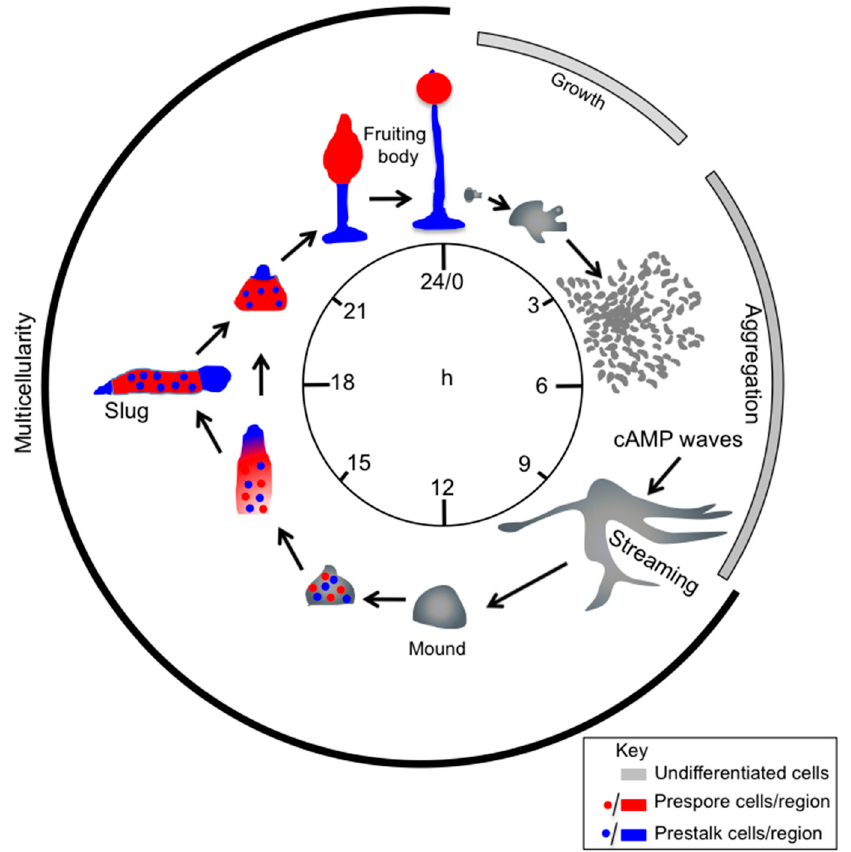
Figure 1. The Dictyostelium discoideum life cycle. Dictyostelium cells grow by feeding on bacteria and dividing by binary fission. Upon exhaustion of nutrients, starving cells start secreting cAMP, which triggers chemotactic motility and aggregation of cells. Aggregation results in the formation of a multicellular organism, a mound, which forms a tip. The tip is a source of continuous cAMP production and acts as an organizer, regulating morphogenesis and differentiation of cells in at least two cell types, pre-spore (red) and pre-stalk (blue) cells, in a proportion of about 80% and 20%, respectively. Following elongation of the tipped mound and toppling onto the substrate, a sausage-shaped organism is formed—the slug-, which migrates for hours, before culminating into a fruiting body. The slug is coated by a cellulose-like extracellular tissue. During slug migration and fruiting body culmination, pre-spore cells sort out in the front region of the slug and on top of the fruiting body, differentiating into spores within a sorus. The pre-stalk cells undergo vacuolation and death, while forming the stalk of the mature fruiting body. The entire process from starvation to formation of the mature fruiting body takes about 24 h (modified from [11]).